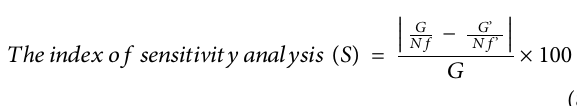
Frontiers in Earth Science |